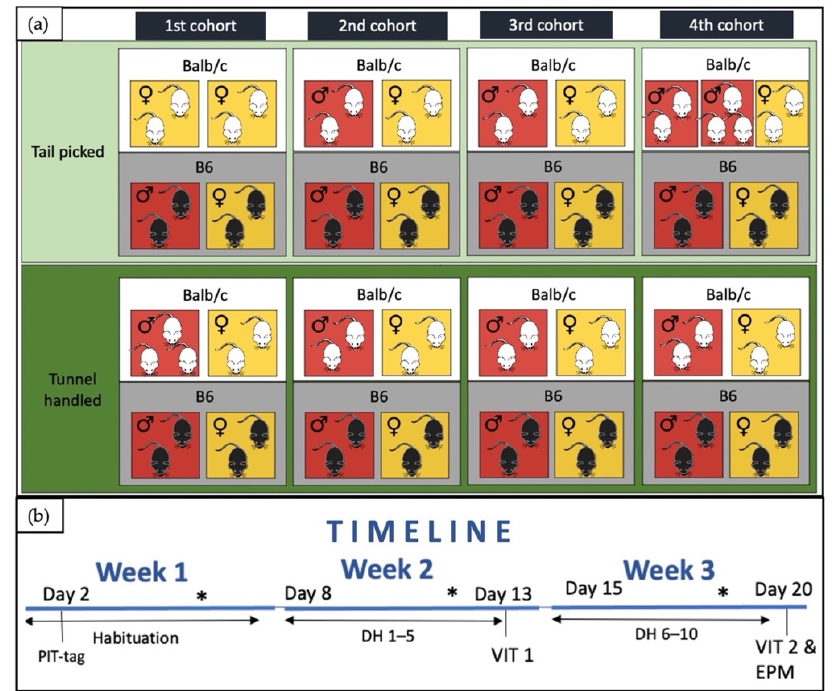
Figure 1. ( a ) Illustration of treatment arrangement for each cohort (showing inclusion of different strains (BALB/cByJ—Balc/c, white, C57BL/6J—B6, black), sexes (yellow—females, red—males)) and handling techniques (light green—tail-picked, dark green—tunnel-handled) and ( b ) timeline illustration of an experimental period for each cohort (PIT-tag—subcutaneous implantation of ther- mosensitive PIT-tag in the dorsal area under short general anesthesia; DH—daily handling for the duration of 10 days performed twice a day; VIT 1—1. trial of voluntary interaction test; VIT 2—2. trial of voluntary interaction test; EPM—elevated plus maze test; *—weekly weight